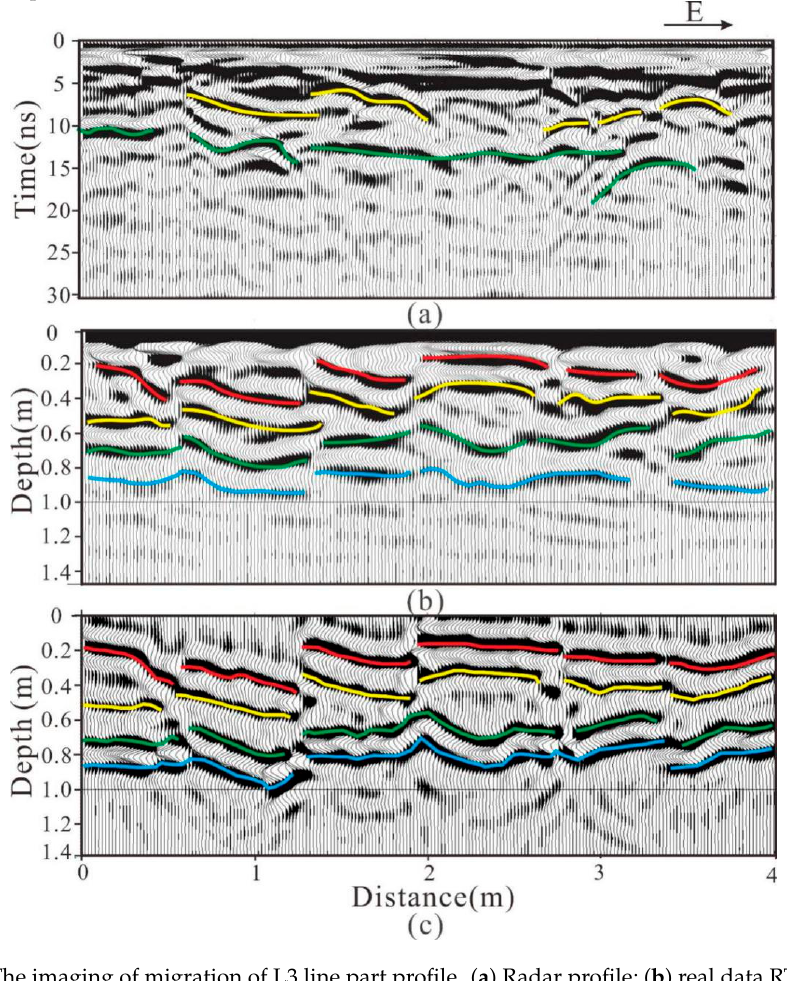
Figure 8. The imaging of migration of L3 line part profile. ( a ) Radar profile; ( b ) real data RTM profile; ( c ) model data RTM profile.